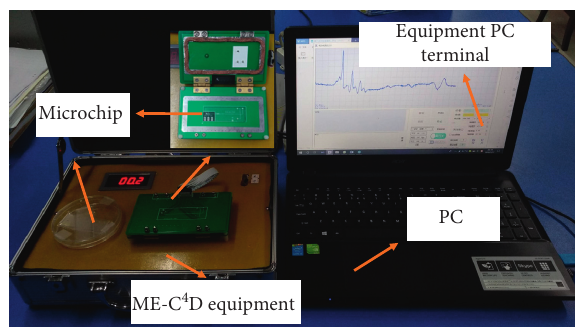
Figure 1: Self-developed ME-C 4 D